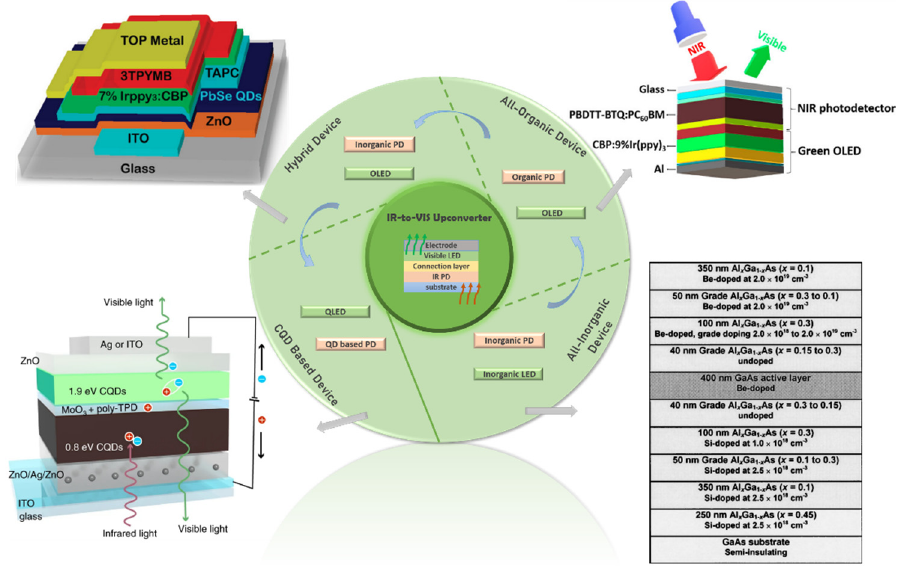
Figure 1. Progress in upconversion devices. The deep green circle in the center shows the repre- sentative structure of upconverters, the light green circle around it demonstrates the main four categories of upconversion devices. The boxes in the light circle show the key differences of different kinds of upconversion devices. These blue arrows in the light circle represent the evolution of upconversion devices. The peripheral pictures are some representative structures of these four kinds of upconverters.